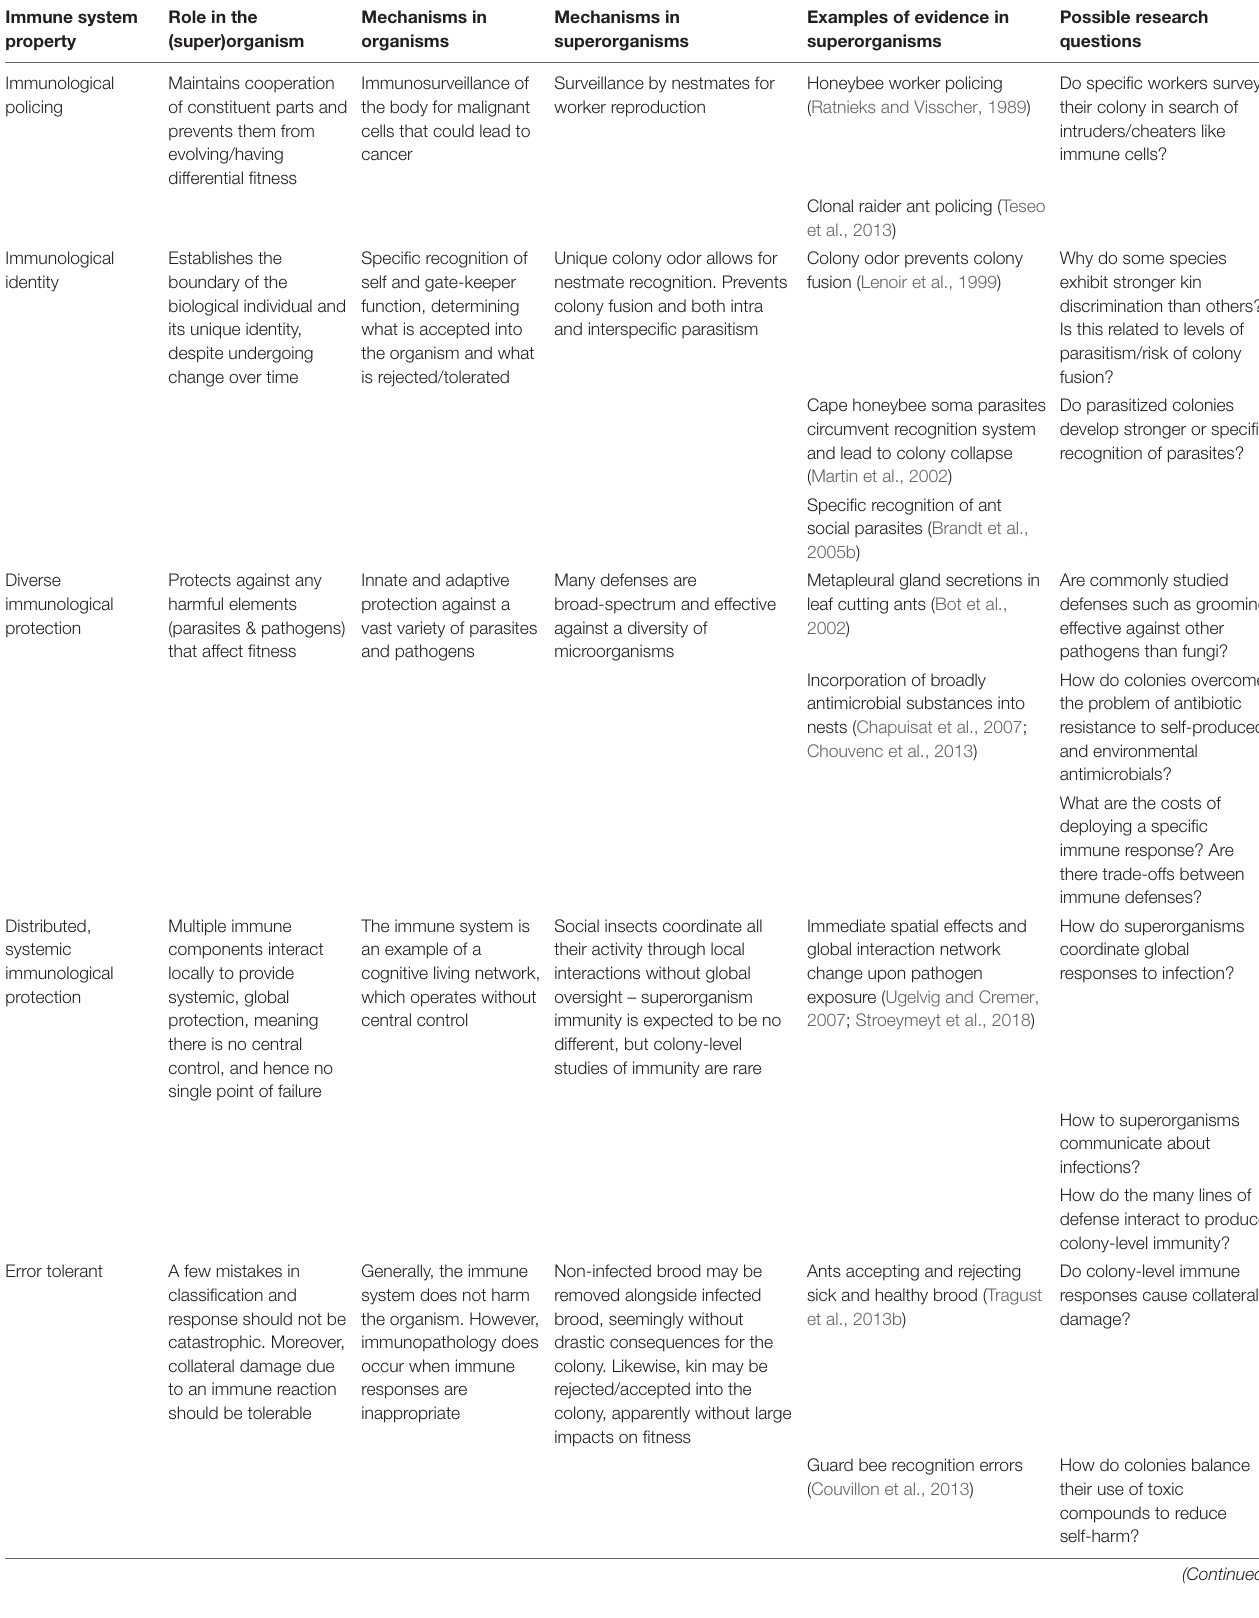
TABLE 1 | Convergent properties of organismal and superorganismal immune